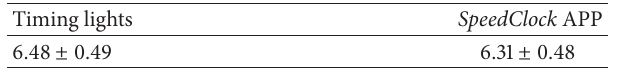
Table 1: Mean flying 10m sprint times for timing lights and SpeedClock APP.